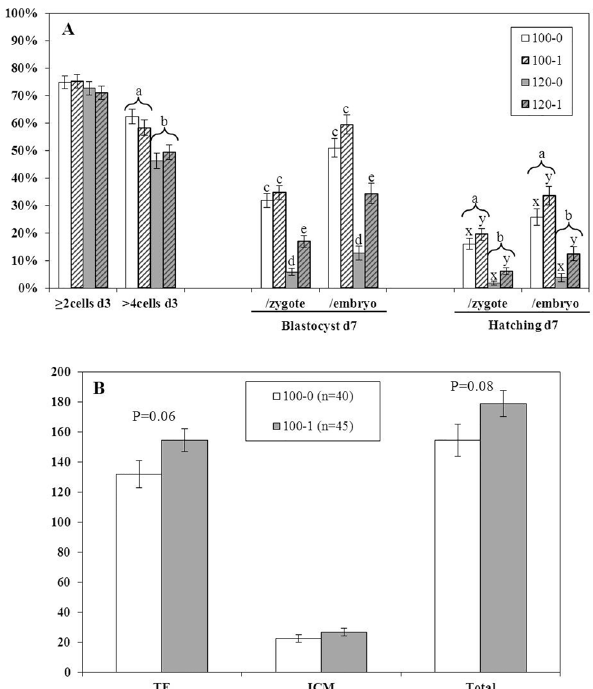
Fig 2. Embryonic development (A) and blastocysts cell numbers (B) for embryos cultured with 100 or 120 mM NaCl and 0 or 1 mM Gly for the first 72 h of culture (zygote to 8-cell). The number of cells in the trophectoderm (TE) and inner cell mass (ICM) and the total number of cells were determined in hatching or hatched blastocysts. Different superscripts indicate a significant (P < 0.05) effect of NaCl ( a,b ), Gly ( x,y ), or the interaction between NaCl and Gly ( c,d,e ). If no superscripts are present, treatments were not different (P > 0.05).